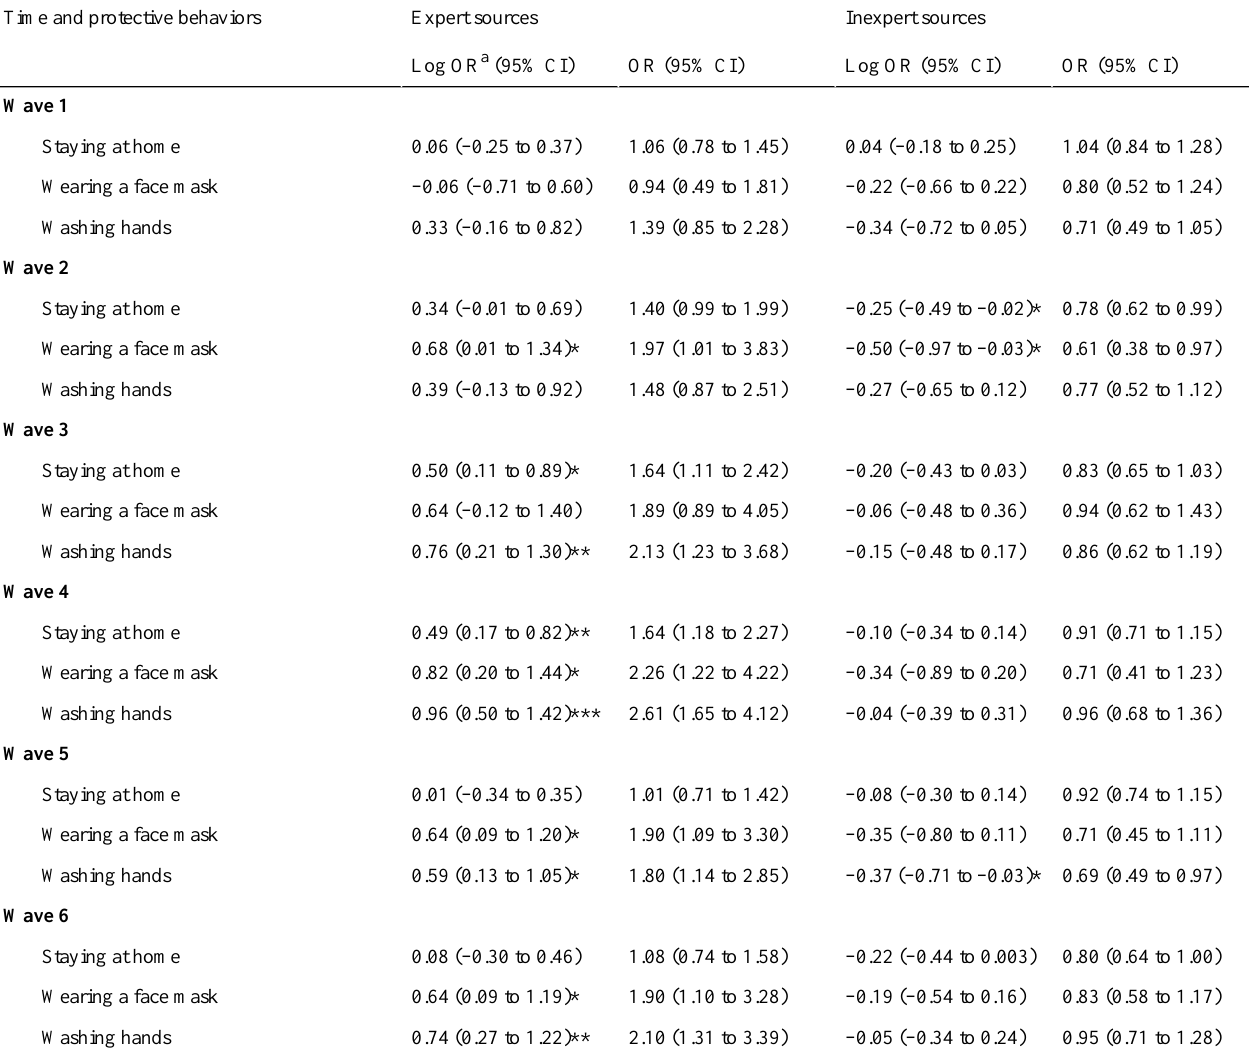
Table 6. The effects of reliance on expert versus inexpert sources on engagement in protective behaviors across time.